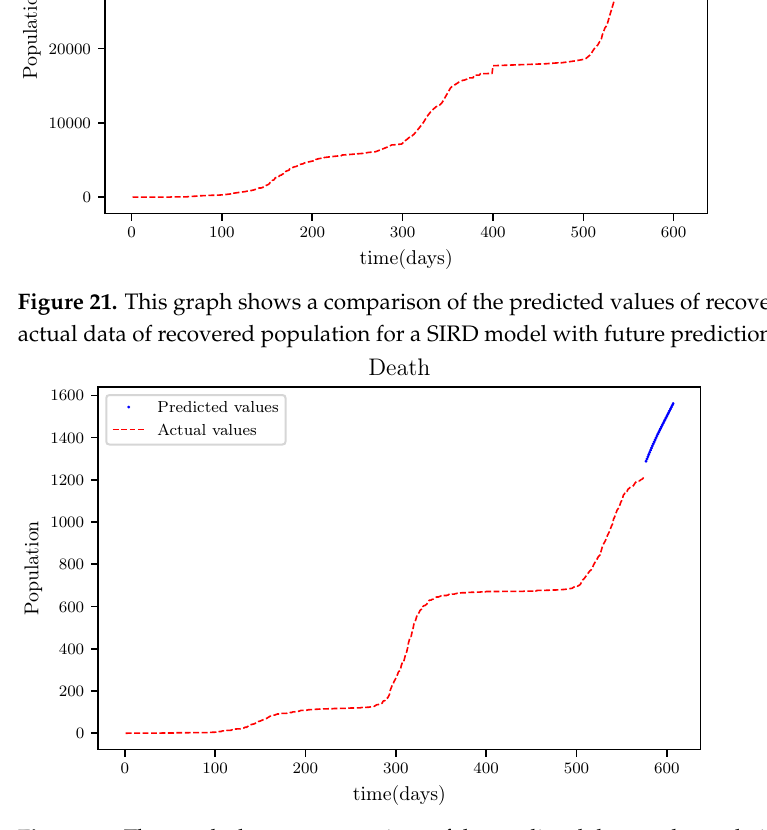
Figure 22. The graph shows a comparison of the predicted deceased population values and the actual data deceased population for a SIRD model with future